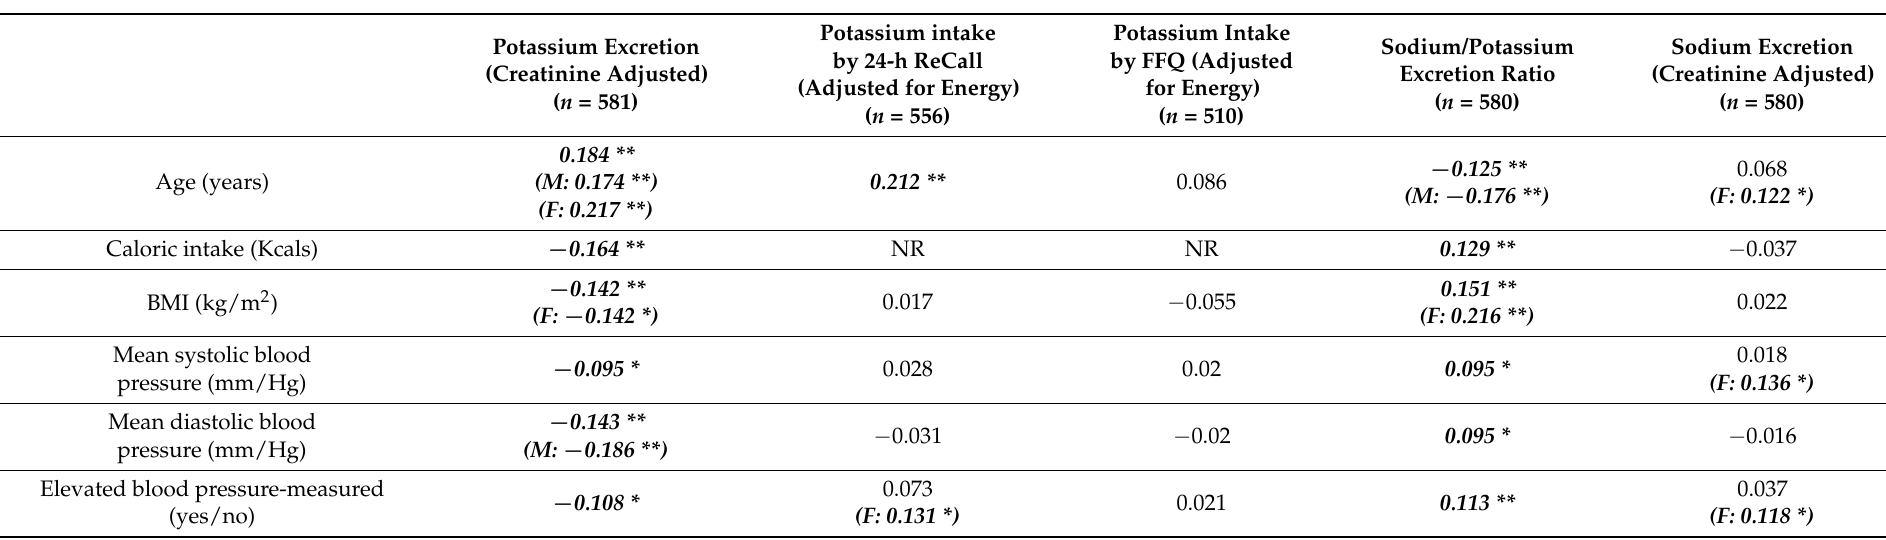
Table 3. Pearson and Spearman correlation coefficients of electrolytes variables and other potential explanatory variables for the metabolic syndrome as well as its